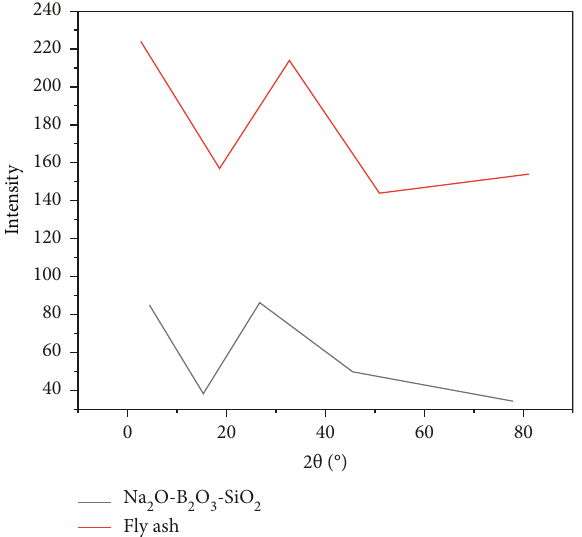
Figure 3: XRD phase analysis of low-temperature foam glass- ceramic